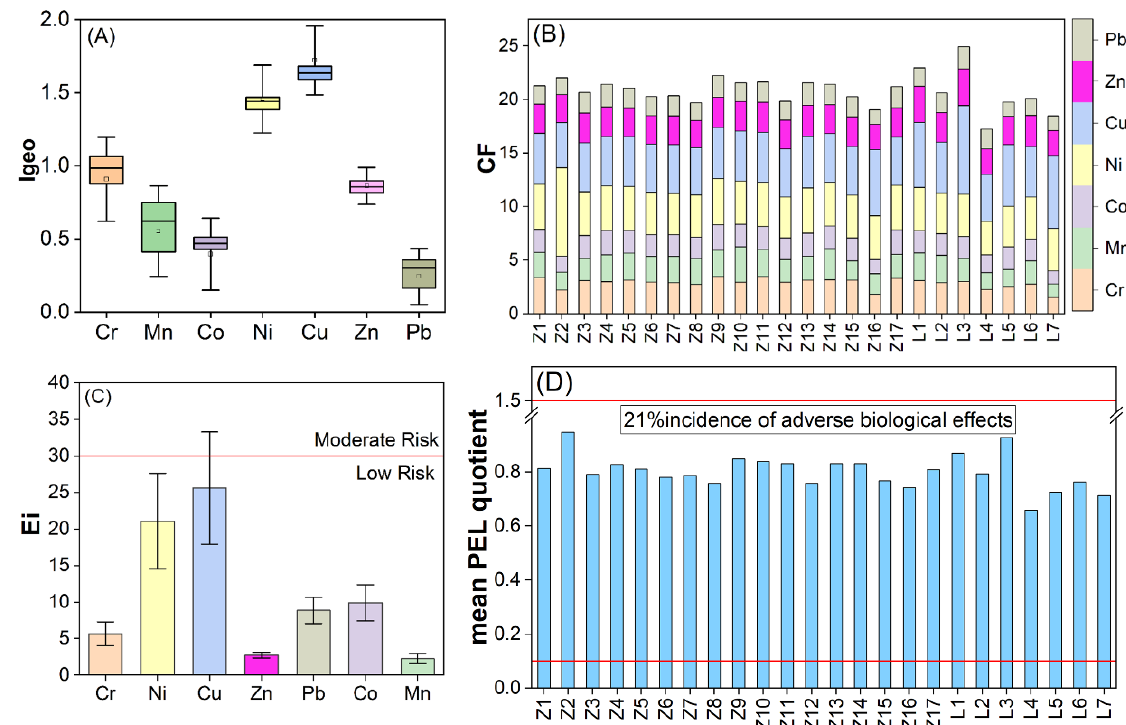
Figure 3. Contamination assessment results of Zhelin Bay: Igeo value ( A ), contamination factor (CF) ( B ), single element ecological risk factor ( E i r ) ( C ), and mean PEL quotient ( D